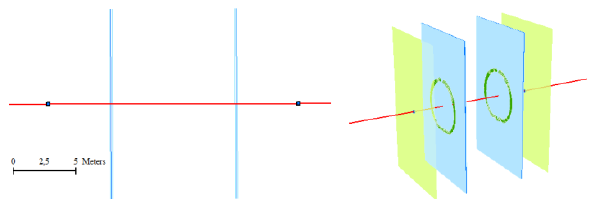
Figure 8. The tunnel axis is cut at 25% and 75% (blue plans).